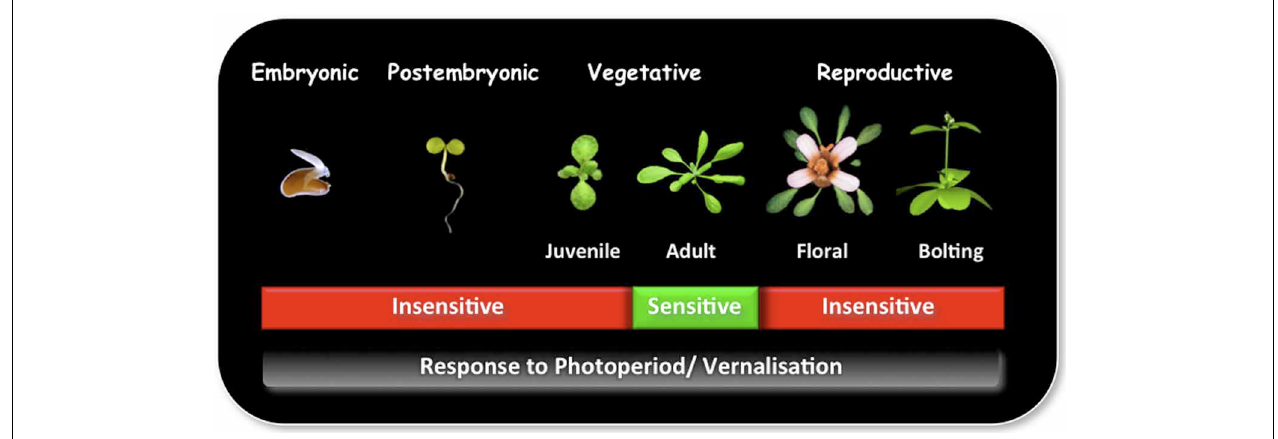
FIGURE 1 | The ability to sense and respond to photoperiod and/or vernalization varies in different phases of development. Plants undergo a series of qualitative transitions during their life-cycle in response to environmental and endogenous factors. One of the most distinguishable is the transition from a vegetative to reproductive phase of development, also known as the transition to flowering. This stage is preceded by the